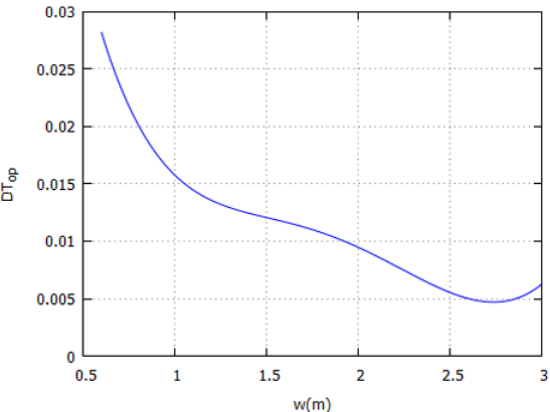
Figure 11. First derivative of the analytical operative temperature for a 21-type radiator, h = 0.3 m.